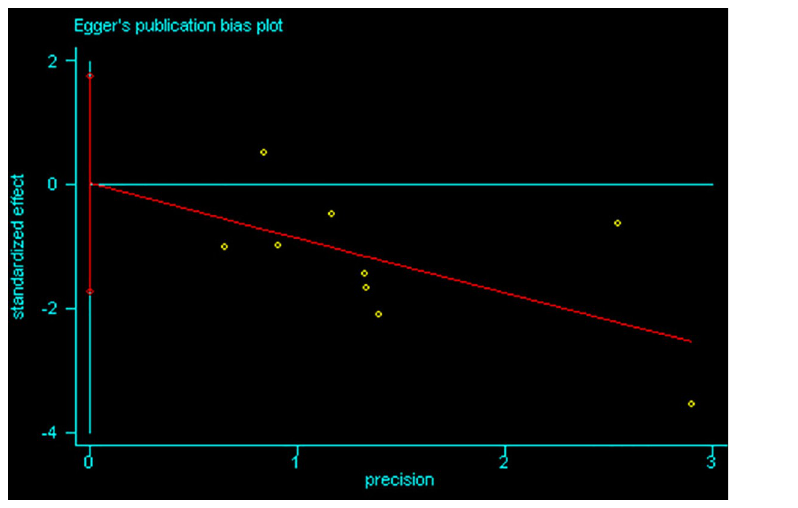
Fig 3. Egger’s regression analysis for publication